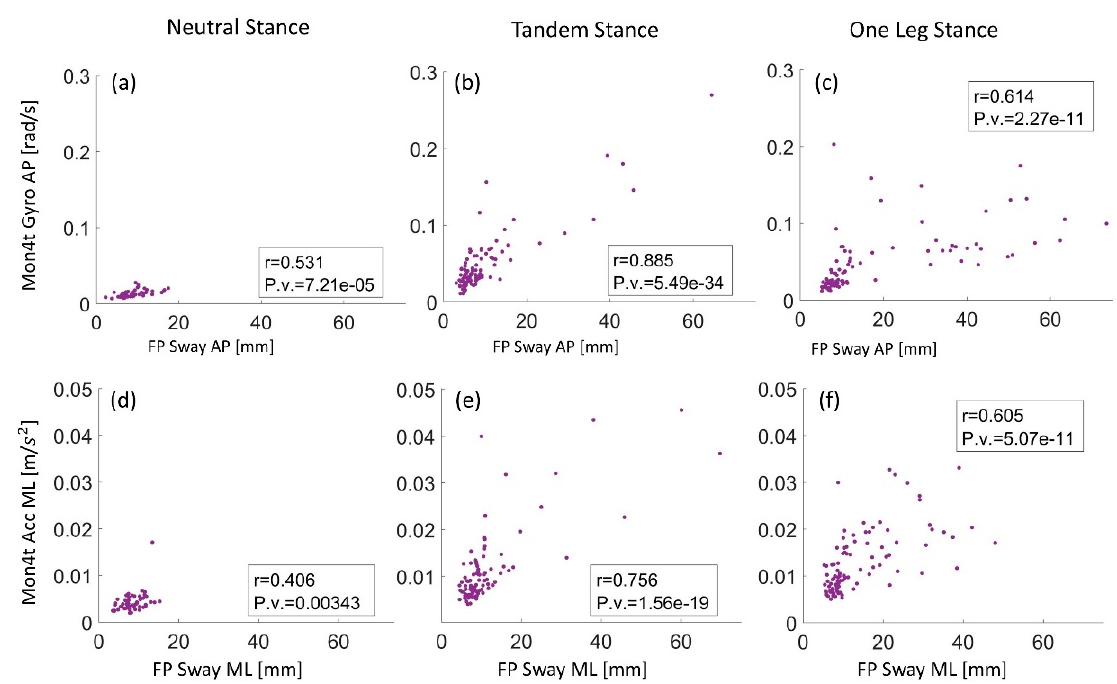
Figure 7. Mon4t vs. force plate (FP) within static sway endpoints. Comparison between the obtained static sway results of both methods in the AP ( a – c ) and ML ( d – f ) directions. ( a , d ) refer to sway performance during neutral stance, ( b , e ) during tandem stance, and ( c , f ) during one-leg stance.